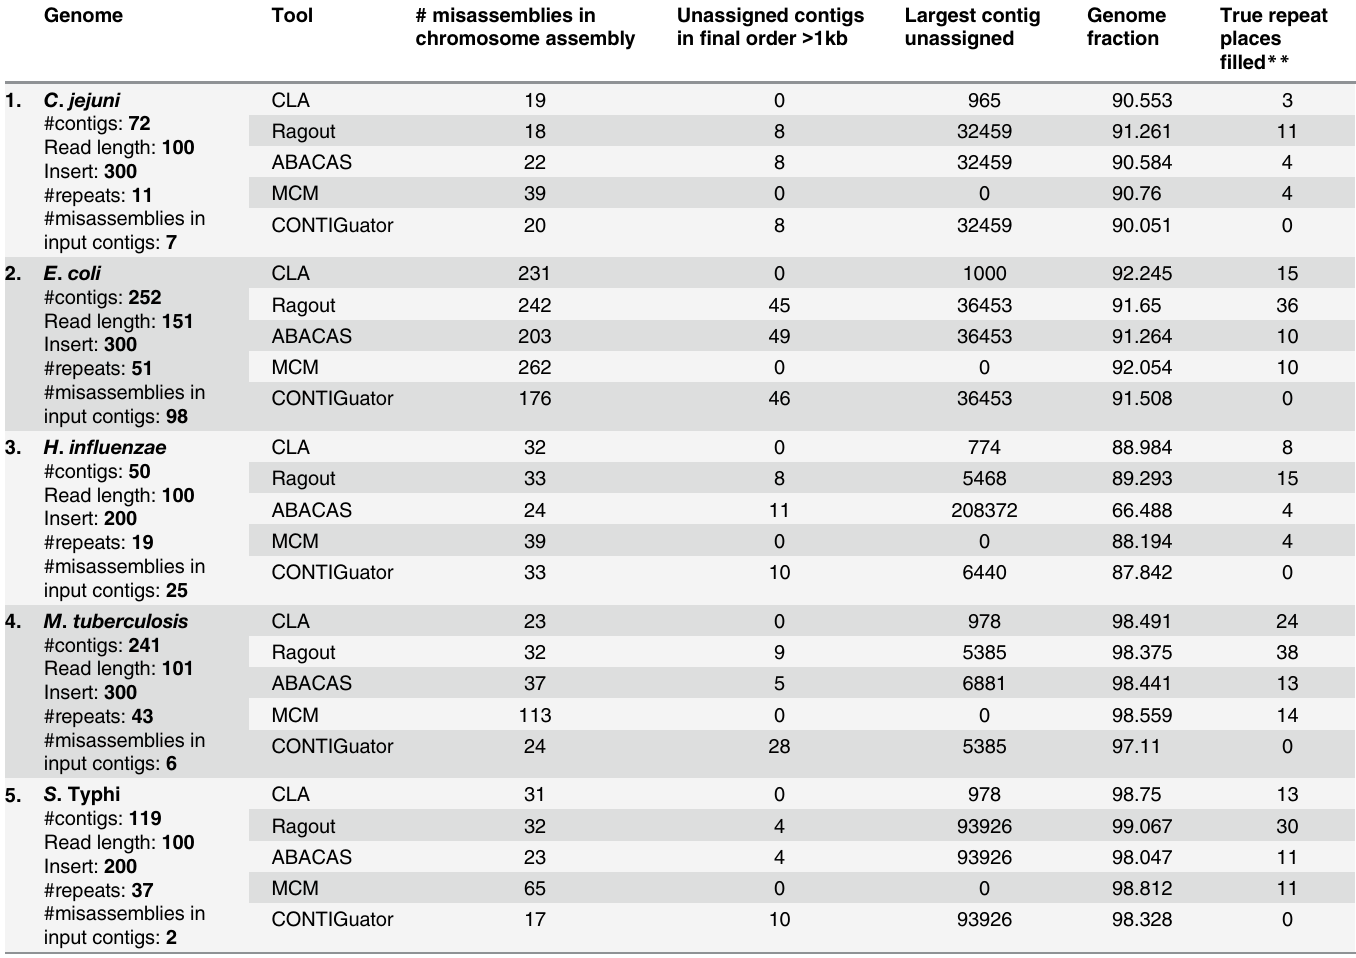
Table 2. Comparative statistics of CLA and reference based alignment tools generated using real dataset.